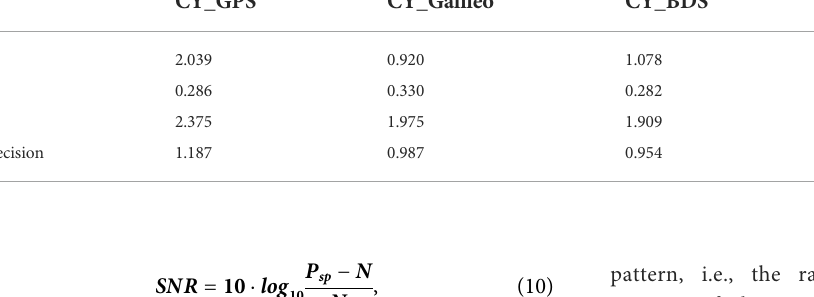
TABLE 4 Coef fi cients of the fi tted curve and potential altimetry precision assuming the elevation angle of 30 ° . CY_GPS CY_Galileo CY_BDS TDS_GPS